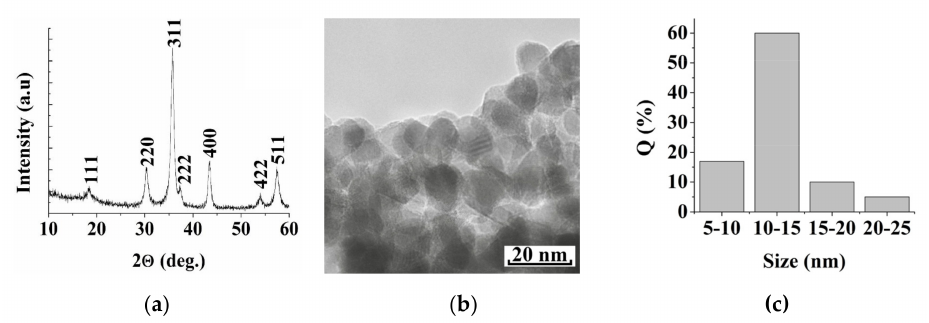
Figure 1. ( a ) XRD–pattern, ( b ) TEM image and ( c ) size distribution histogram of cobalt ferrite particles synthesized by anion-exchange resin co-precipitation in a solution of FeCl 3 , CoCl 2 and 10% dextran–40 at 60 ◦ C and annealed at 600 ◦ C for 1